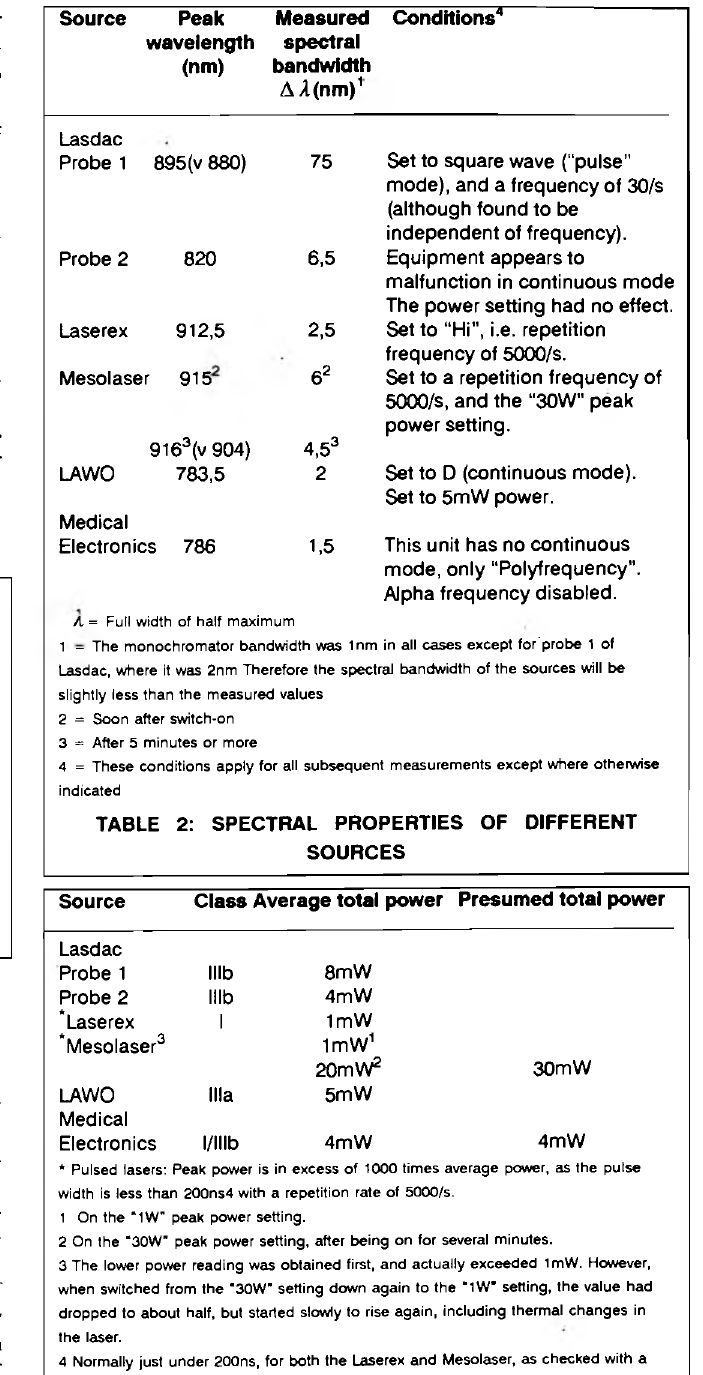
TABLE 3: RADIANT